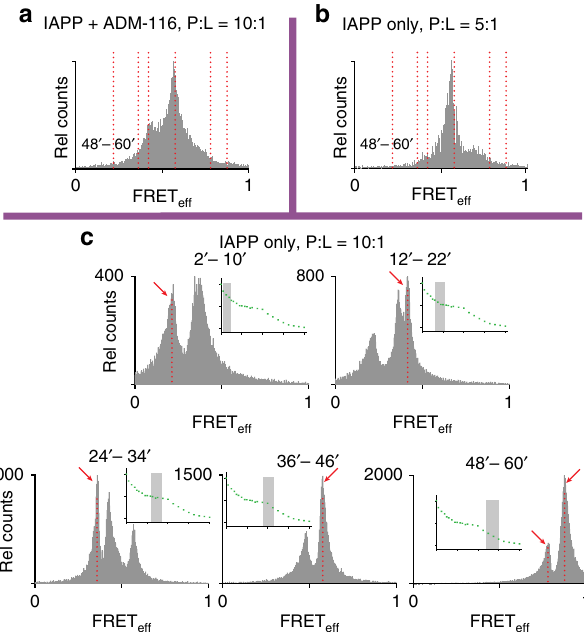
Fig. 8 Structural changes within IAPP oligomers occur on the same timescale as poration. a Intermolecular FRET histograms at 10:1:10 IAPP: lipid:ADM-116 summed over a minimum of three GPMVs, fi ve optical sections for each GPMV and the indicated periods of time. Conditions and confocal fl uorescence data collection are matched to those shown in Fig. 7. b As in a but at 5:1:0 IAPP:lipid:ADM-116. c Diluted-FRET at 10:1:0 IAPP: lipid:ADM-116. Pixel statistics correspond to summation across the indicated time period. Red arrows indicate peaks used to de fi ne FRET eff values for species referred to in the main text and the locations of dotted red lines in b . Inset: Schematic of leakage pro fi le collected under matched conditions (Fig. 1d). Grey rectangles show the time period over which FRET eff is summed in the associated